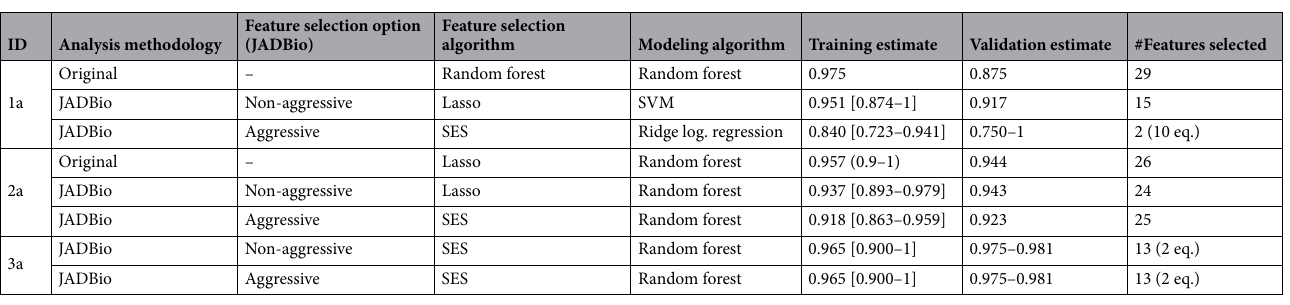
Table 1. Predictive performance estimates in terms of AUC reported in the original dataset publication and by JADBio on training and validation sets. Numbers in parentheses denote the range of the estimate while the numbers in brackets the 95% confidence intervals. (see Supplementary Table 1 for more results and links to the JADBio platform). The equivalences denote the number of equivalent signatures delivered by JADBio, e.g., “2 (10 eq.)” meaning that JADBio delivered 10 equivalent signatures each containing 2 biomarkers. In the 3a case the same model was generated when either the aggressive or the non-aggressive feature selection option was